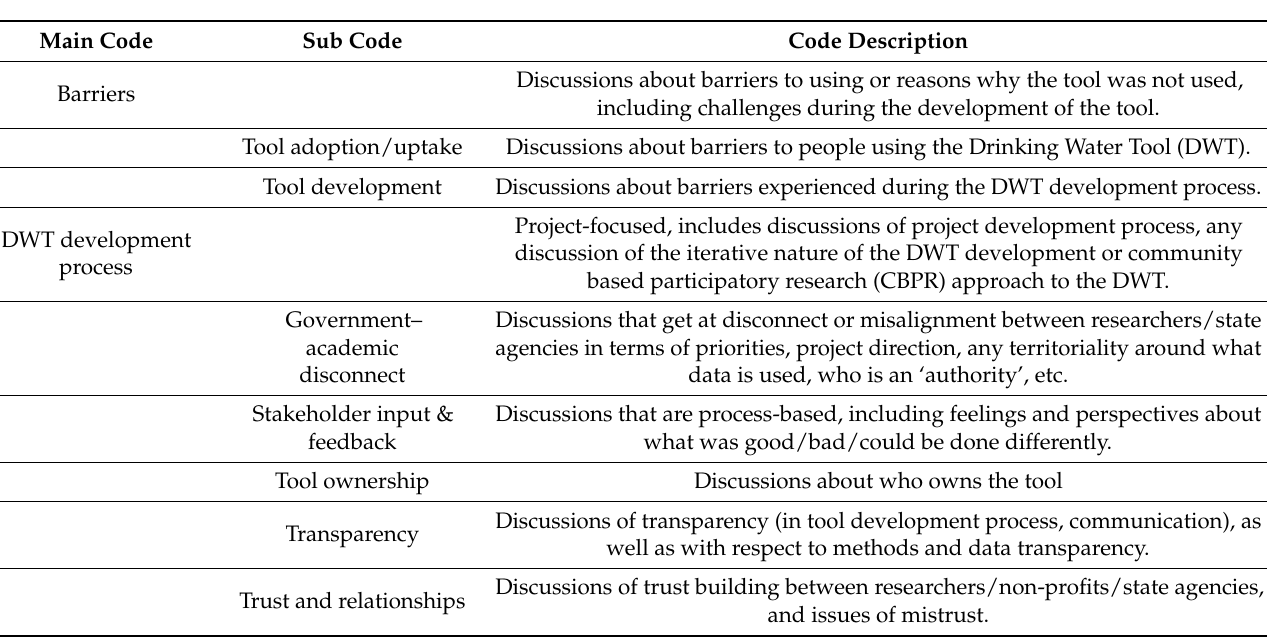
Table A2. Themes from